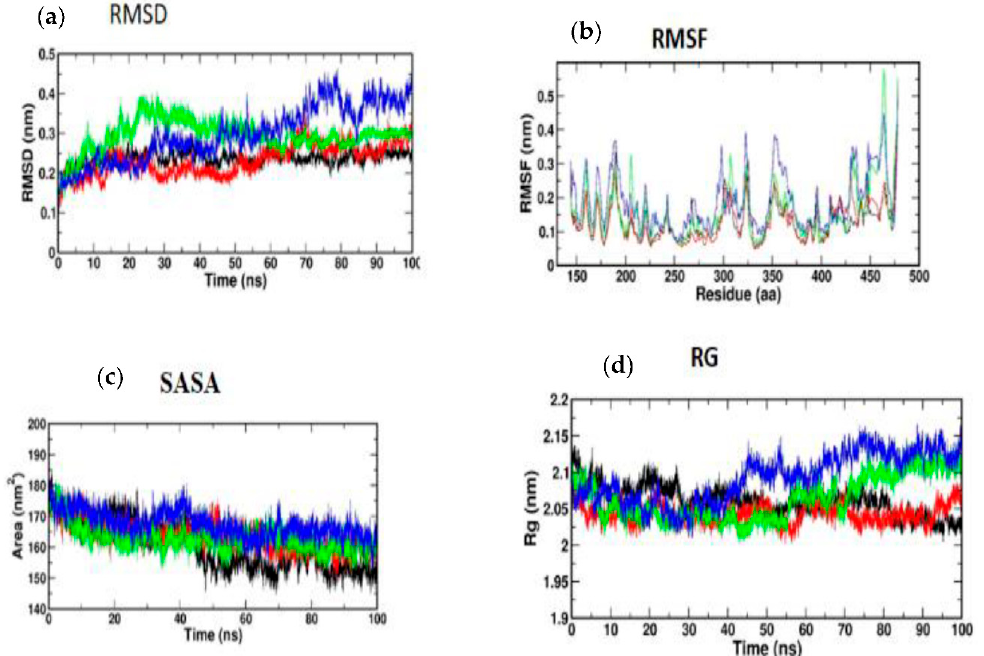
Figure 9. ( a ) RMSD; ( b ) RMSF; ( c ) SASA; ( d ) RG of Akt protein with the top three compounds. Caffeic acid shown in red; p-coumaric acid (green); trans-ferulic acid (blue).